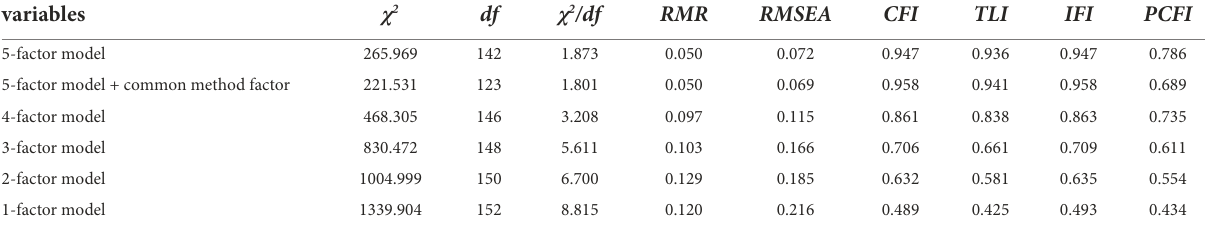
TABLE 3 Confirmatory factor analysis results.